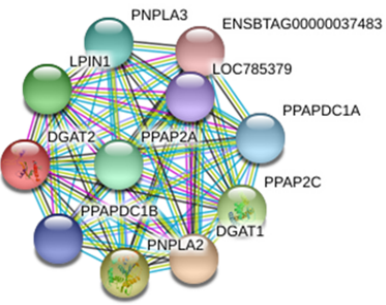
Figure 8. Protein–protein interaction network of DGAT2.